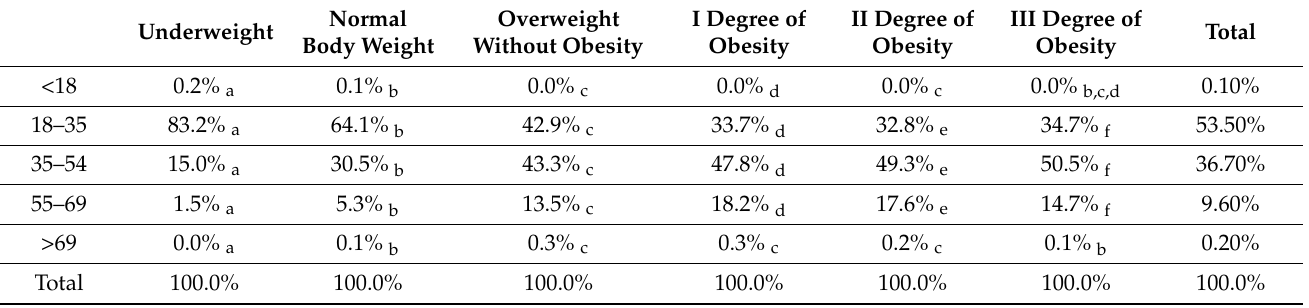
Table 5. Relationship between BMI and age of patients; data presented as percentage of the BMI category 1